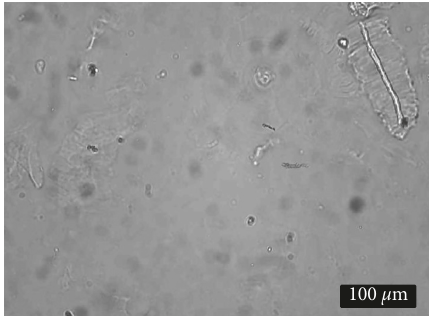
Figure 4: Optical micrographs of a hydrogel sample made by polyelectrolyte complexation of CS 0.016% w/v over CMC 0.8% w/v. Scale